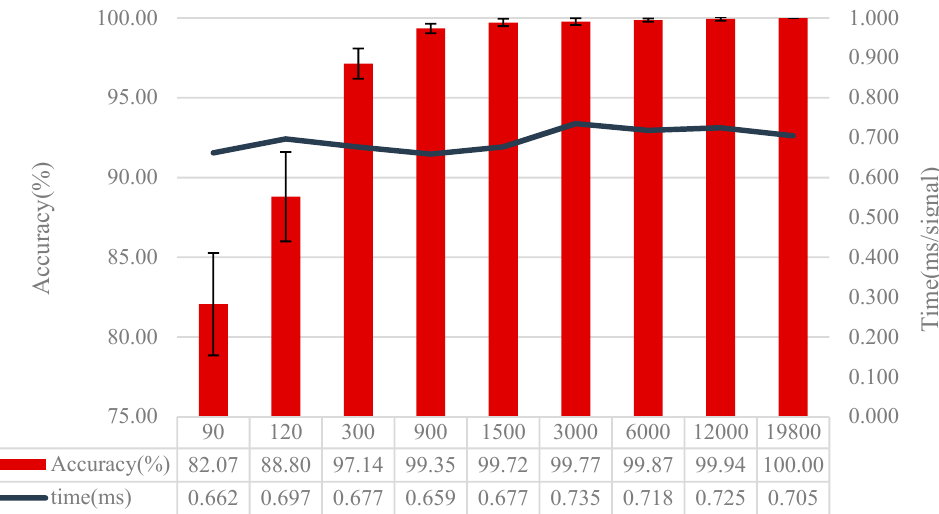
Figure 7. Diagnosis results using different numbers of training samples.